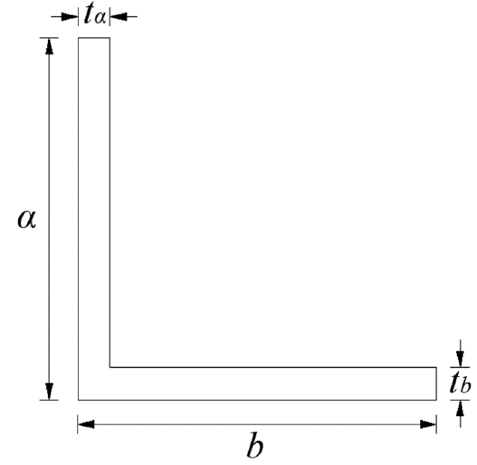
Figure 1. Cross-section geometry and adopted notation for angles.